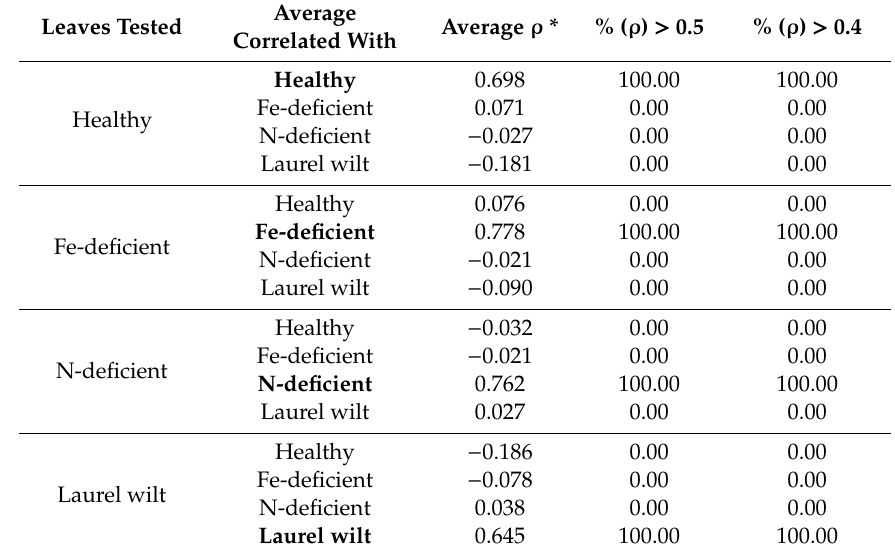
Table 1. Summary of Bivariate Correlations for Avocados. Diagnostic accuracy of FDA-BC method of disease plant classification for various avocado deficiencies.